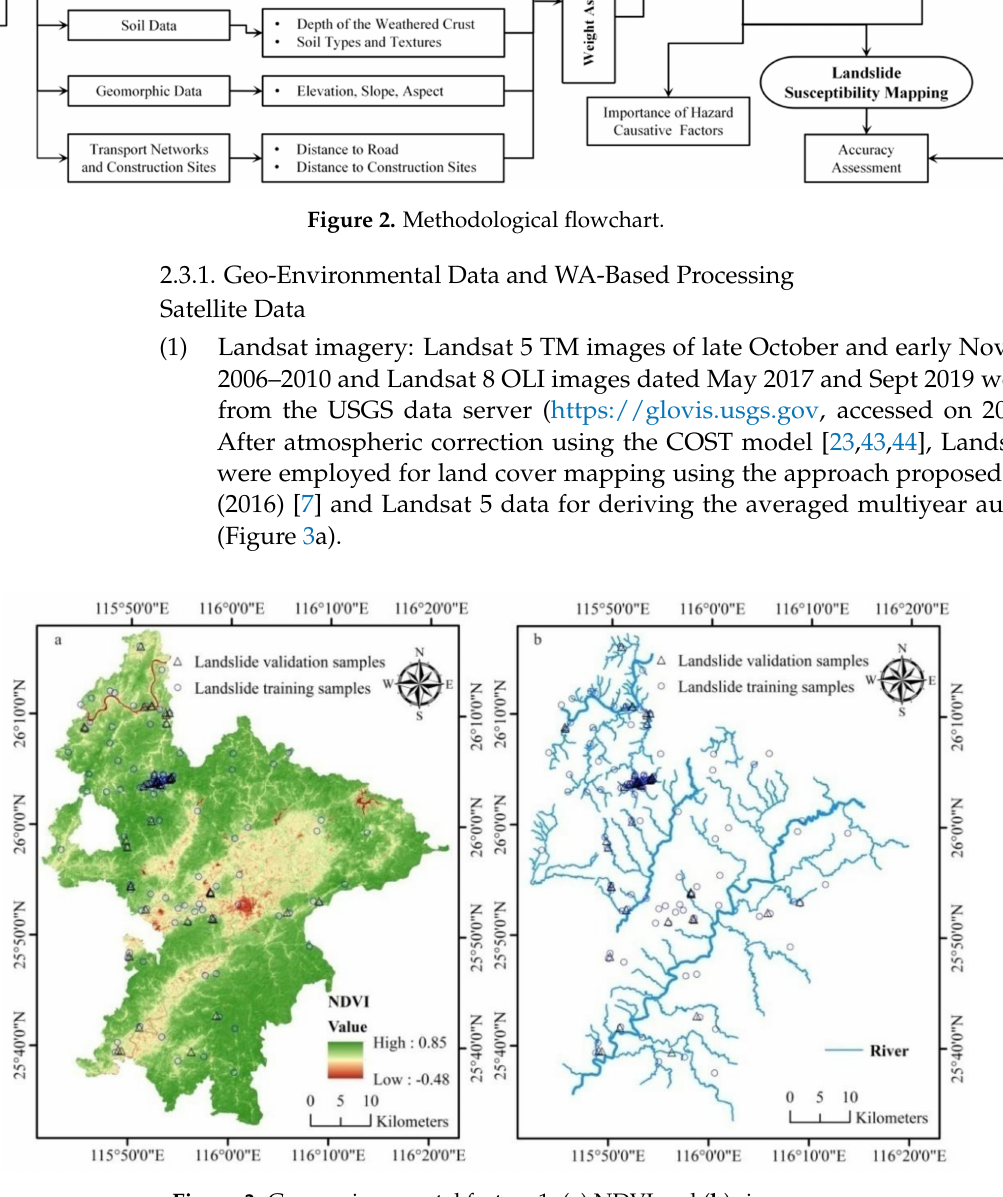
Figure 3. Geo-environmental factors 1: ( a ) NDVI and ( b )